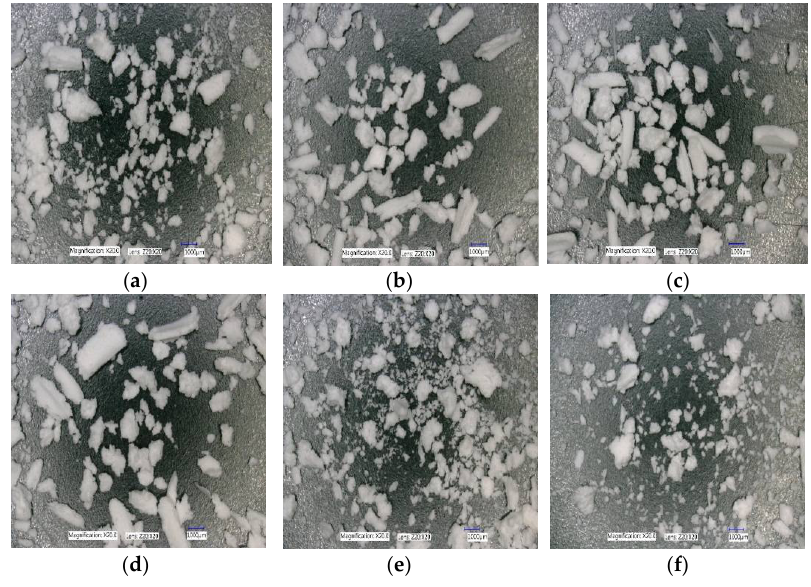
Figure 18. Microscopic images of MCC granules produced at varying screw speed at SFL—0.041